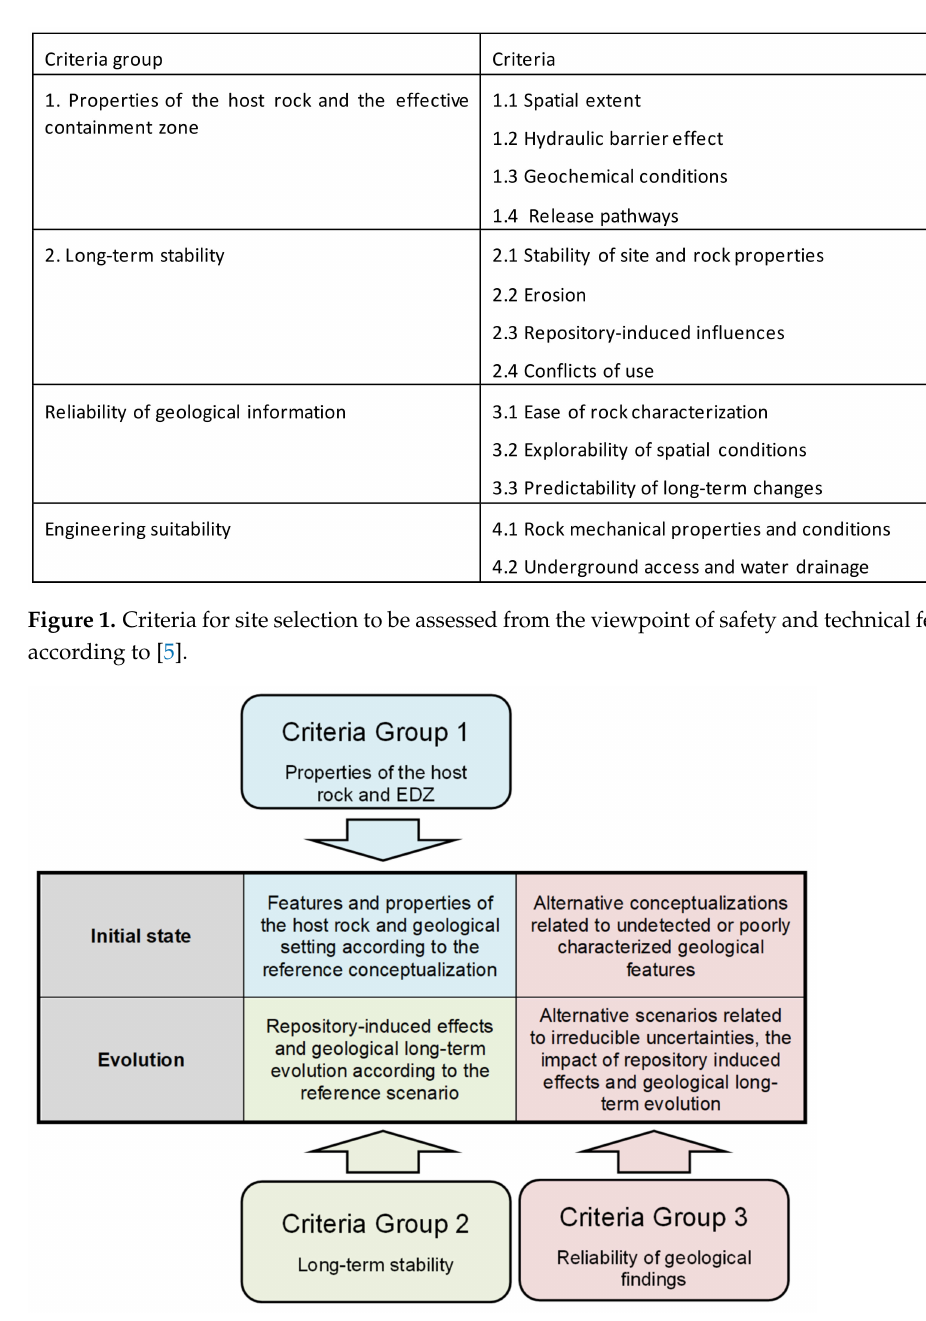
Figure 2. Focus of performance assessment in the evaluation of Criteria Groups